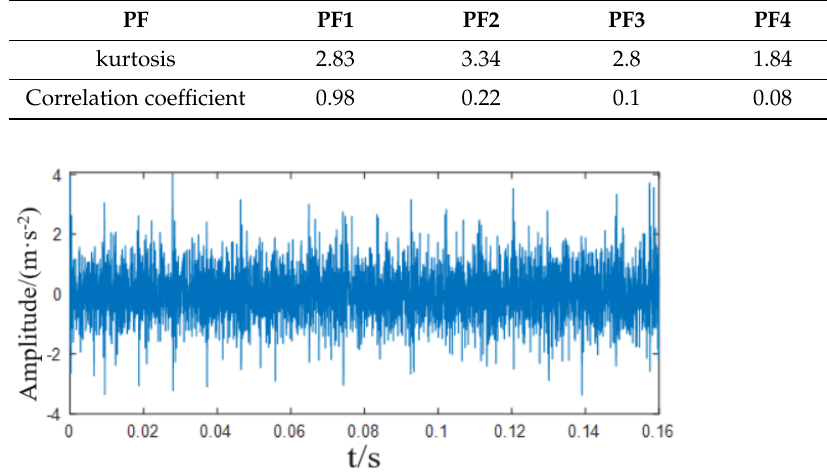
Figure 11. Time-domain diagram of the reconstructed experimental signal. The SSA-CYCBD algorithm is used to denoise and separate the faults of the experimental reconstructed signals. First, the faults of the outer ring are separated. The